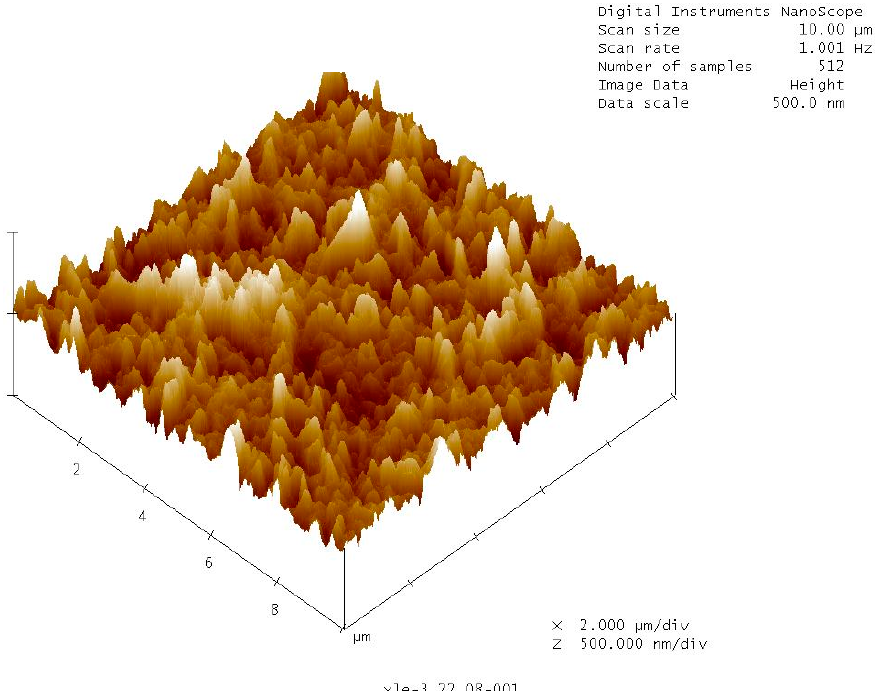
Figure 3. Atomic force microscopy (AFM) image of a polyamide membrane showing representative roughness. Courtesy of Eric M.V. Hoek (reprinted with the permission of Elsevier B.V.) [40].